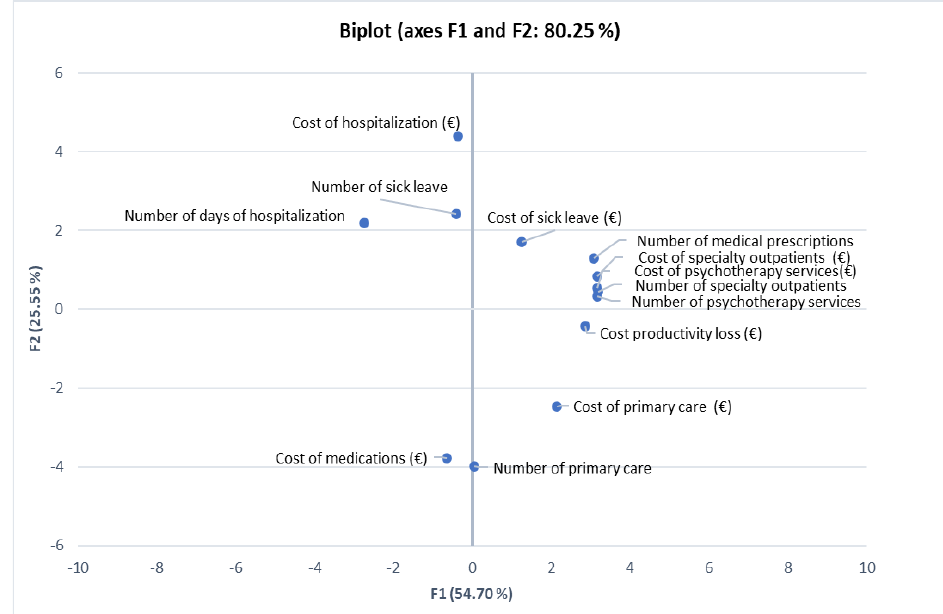
Figure 5. Representation of variables in the system of the first two factorial axes.